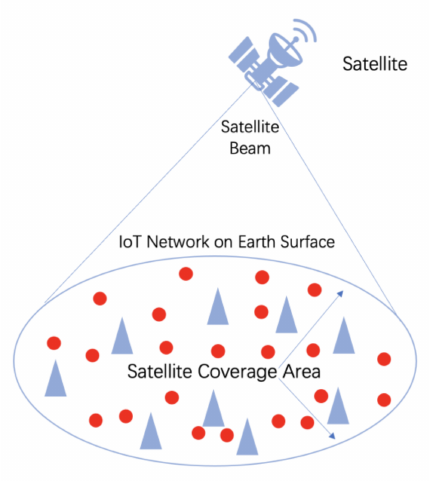
Figure 2. Satellite-based IoT